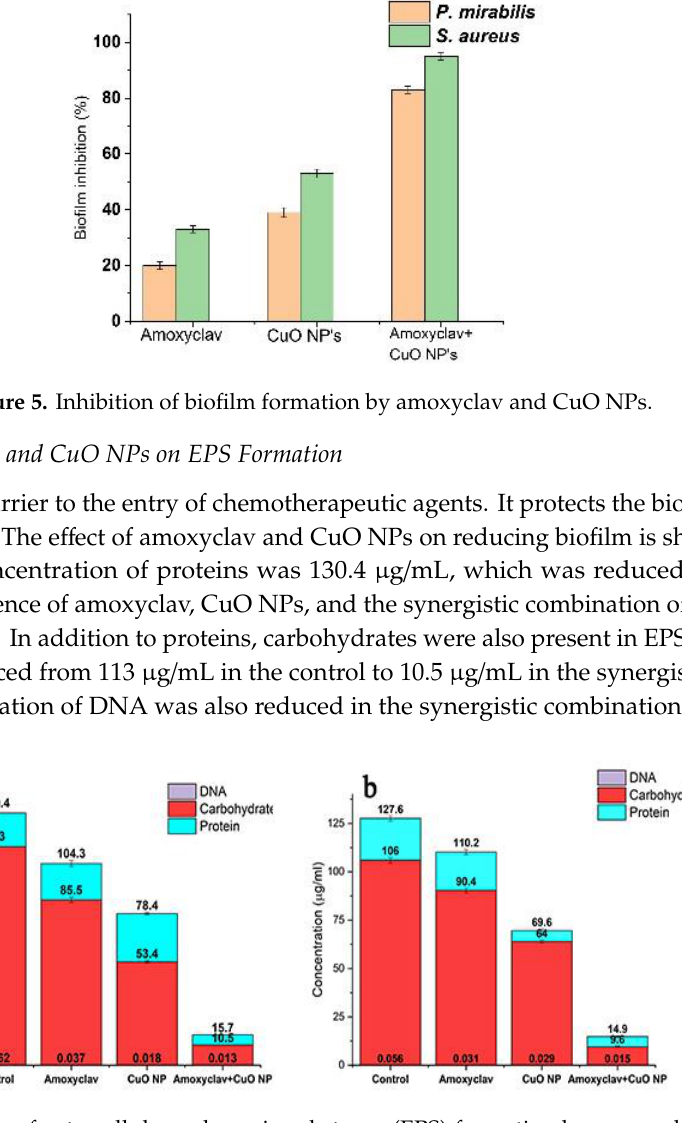
Figure 4. Time-dependent destruction of bacteria by amoxyclav and CuO NPs on ( a ) P. mirabilis ; and ( b ) S. aureus.